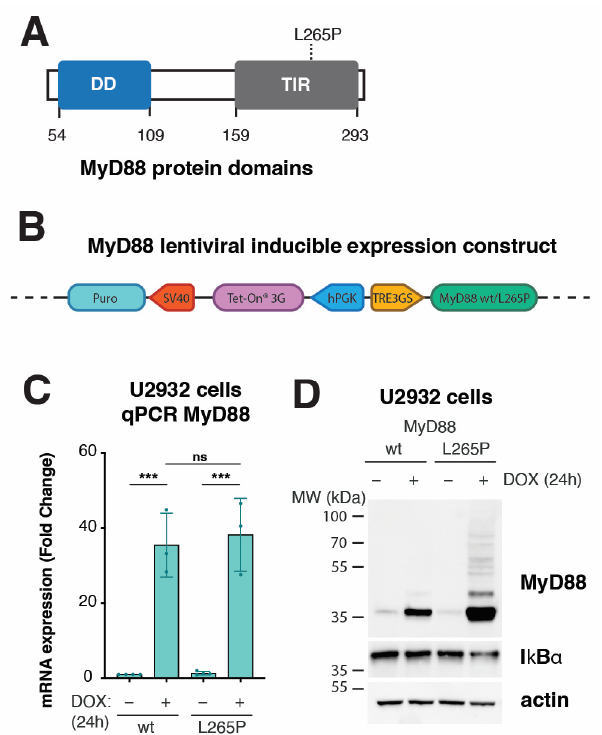
Figure 1. Development of inducible system to express MyD88 wt or L265P in lymphoma cell lines. ( A ) Schematic representation of MyD88 protein domains. The missense mutation (L265P) is located at the TIR domain at the C terminus. ( B ) Schematic representation of the tetracycline-inducible lentiviral gene expression system, pLVX-TetOne-Puro, used for the overexpression of MyD88 (wt/L265P) in stable cell lines. The Tet-On 3G transactivator is constitutively expressed under the human PGK promoter. The MyD88 gene (NM_002468.5) is under the TRE3GS promoter in the opposite orientation. In the presence of doxycycline (DOX), the Tet-On 3G transactivator binds and activates the TRE3GS inducible promoter that controls MyD88 expression. The gene sequence encoding cell selection marker puromycin N-acetyltransferase (Puro) under the simian virus 40 (SV40) promoter confers puromycin resistance. ( C ) MyD88 inducible expression analyzed with qPCR after 24 h of DOX (250 ng/mL) treatment in U2932 cell lines (ns, not significant for p > 0.05, *** for p ≤ 0.001). ( D ) Western blot analysis of MyD88 inducible expression after 24 h of DOX (250 ng/mL) treatment in U2932 cell lines. IkB α staining was used as a marker for NF-kB pathway activation. Actin was used as a loading